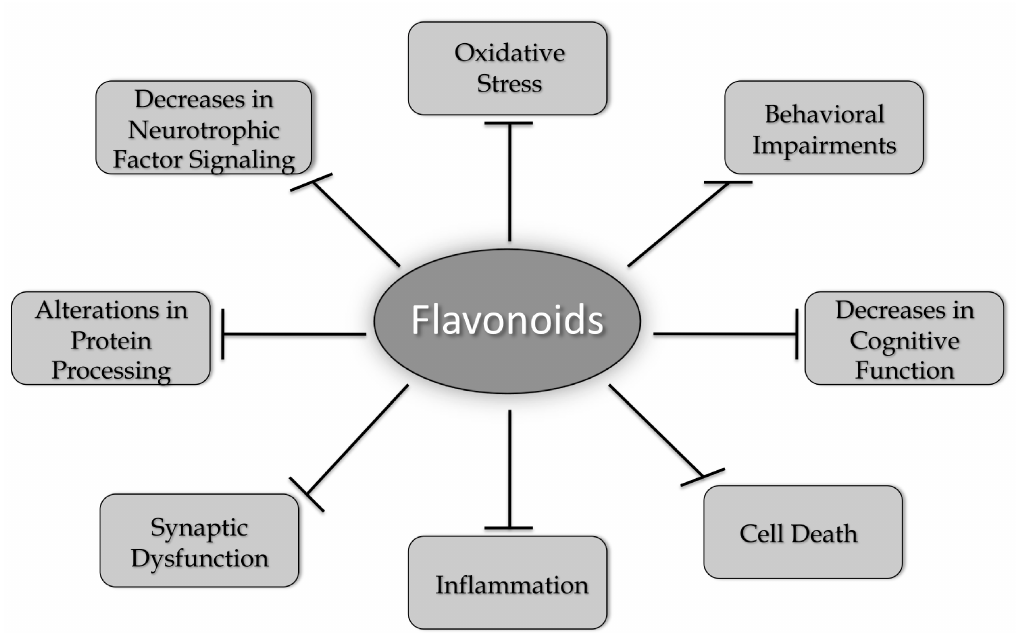
Figure 2. Flavonoids alter multiple pathways implicated in brain aging and neurodegenerative